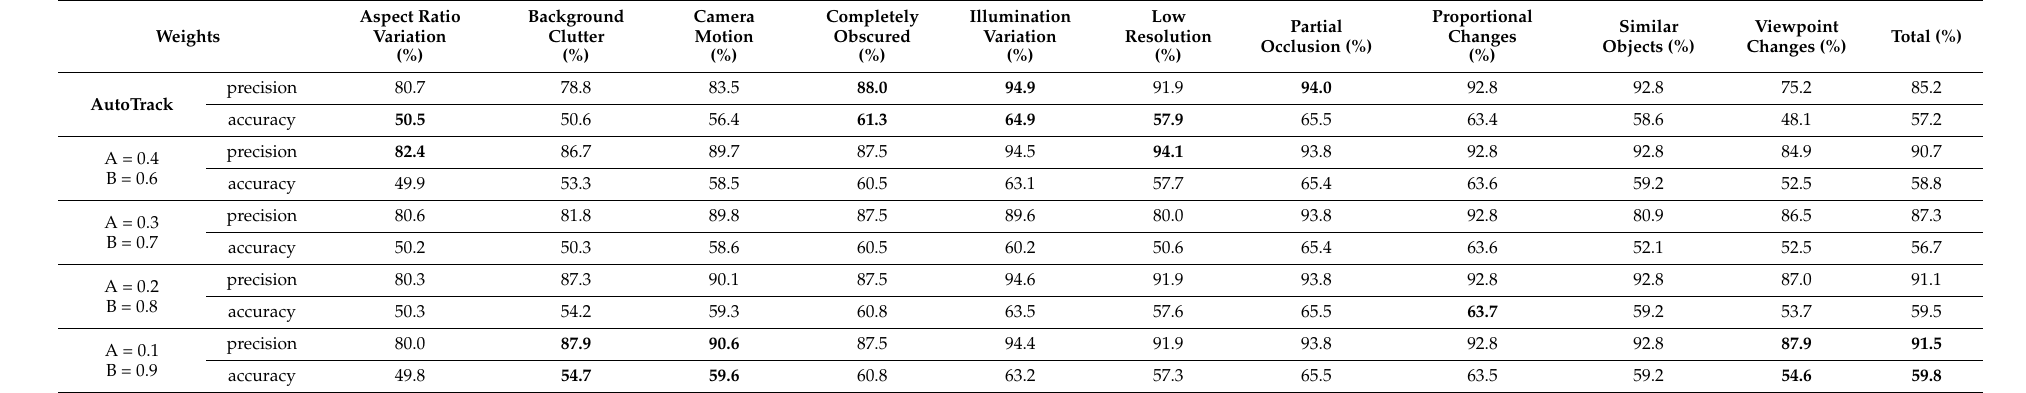
Table 3. Comparison of precision and accuracy under different